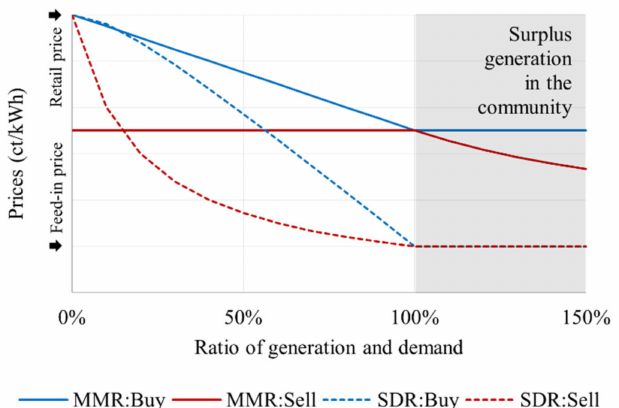
Figure 1. Electricity buying and selling prices within a microgrid according to the MMR and SDR pricing